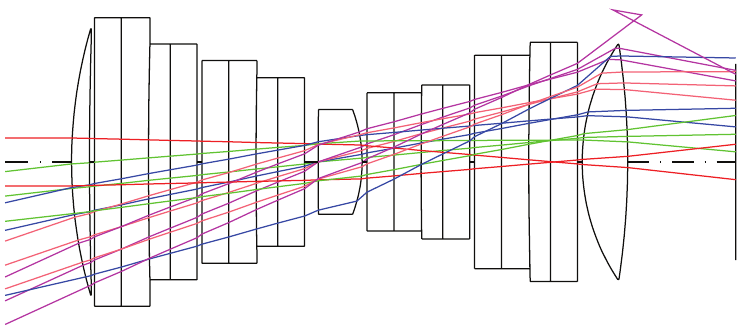
Figure 2: Initial lens layout.